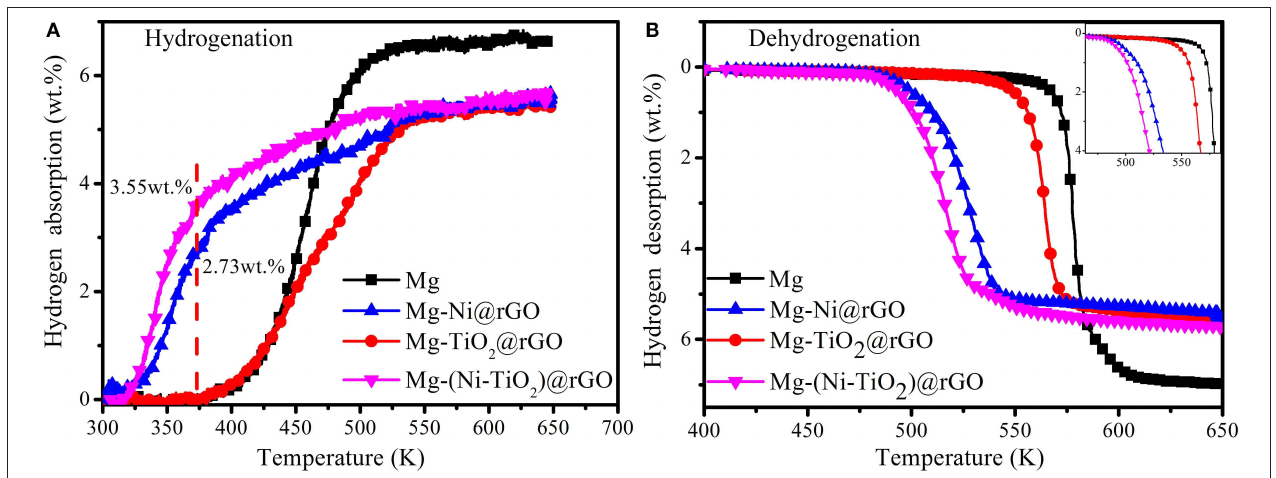
FIGURE 5 | Hydrogenation (A) and dehydrogenation (B) curves of Mg and Mg-Ni@rGO, Mg-TiO 2 @rGO, and Mg-(Ni-TiO 2 )@rGO